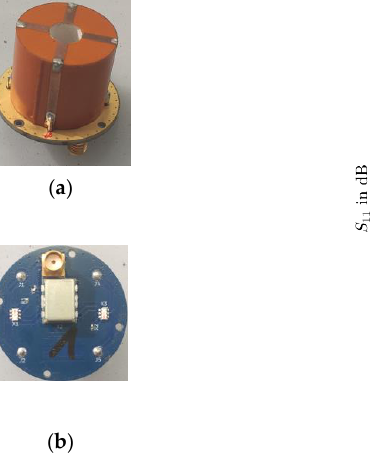
Figure 2. Wideband annular cylindrical dielectric resonator antenna module. ( a ) Resonator body with conductive conformal feed-strips glued on a circular piece of PCB, acting as ground plane; ( b ) Quadrifilar feed-network on the backside of the PCB with SMA connector and soldered pins to connect to the feed-strips of the DRA; ( c ) Comparison of simulated and measured S-parameters and realized RHCP gain values at the zenith of the antenna module.